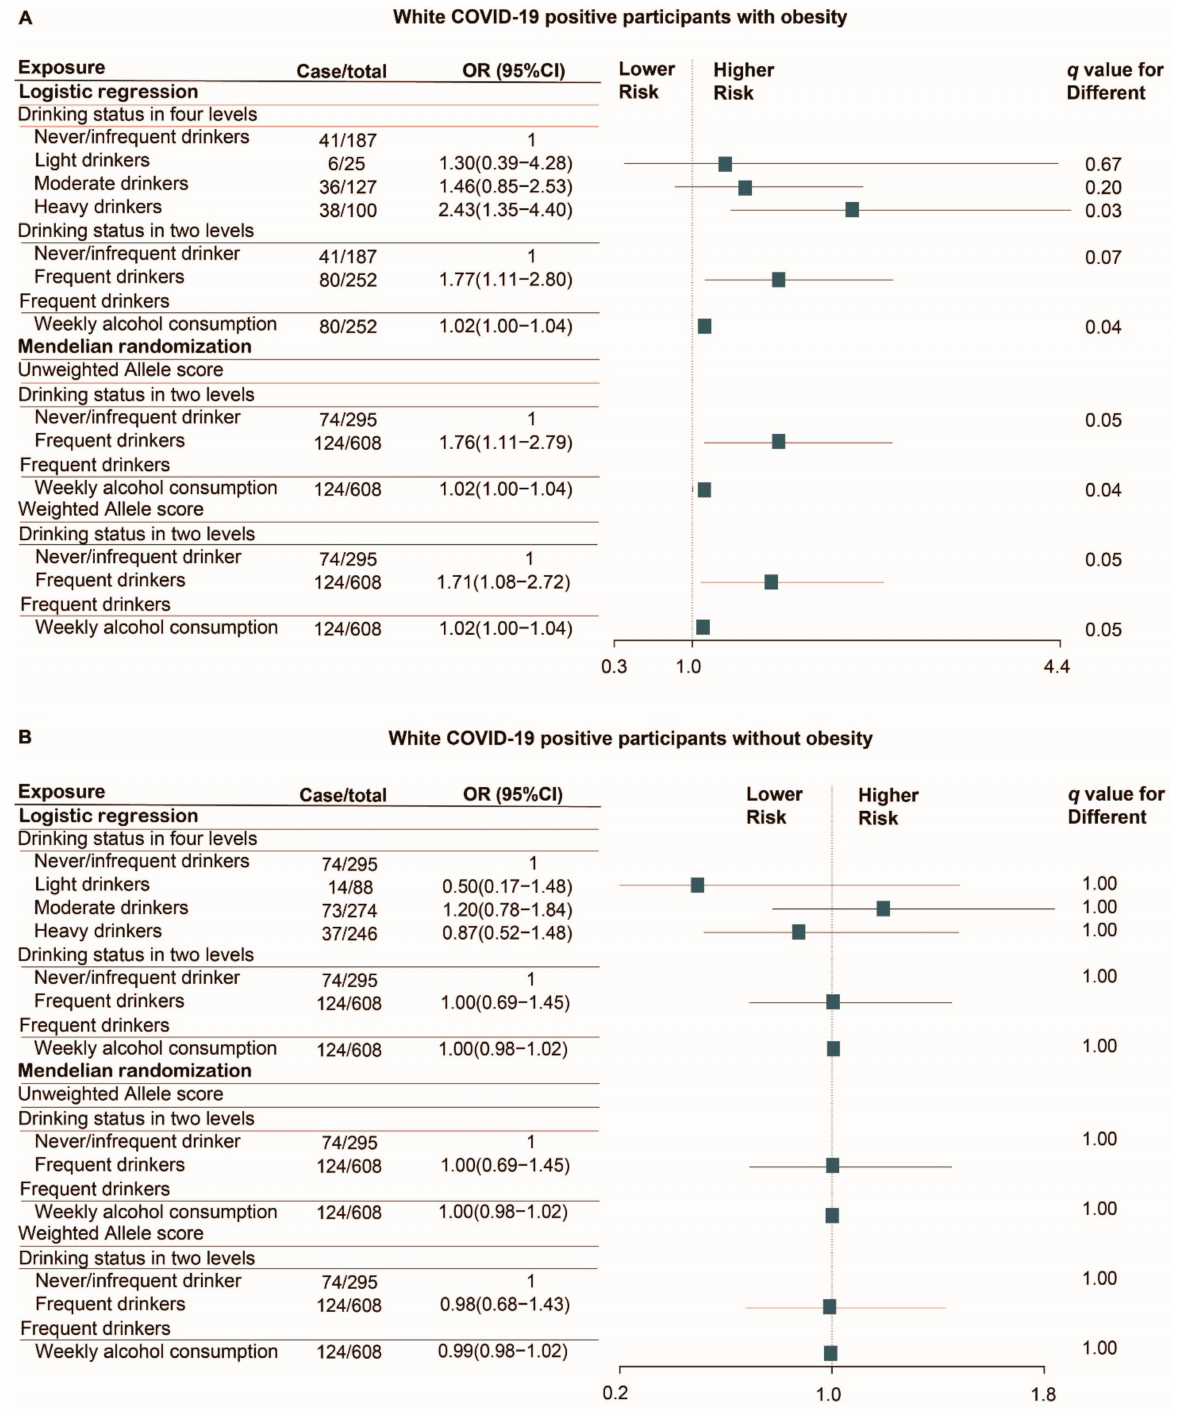
Figure 4. Logistic regression and Mendelian randomization analyses of the association of alcohol consumption with the risk of severe clinical outcomes in white COVID-19 positive patients with ( A ) and without obesity ( B ). Analyses were performed in PSM cohort (Number of cases was counted from the cohort before PSM). Matching factors for PSM including age, sex, BMI categories, current smoking status, alcohol related diseases, asthma, emphysema, COPD, bronchitis/bronchiectasis, esophagitis, gastritis/duodenitis, peptic ulcer, GERD, hypertensive, chronic ischemic heart disease, heart failure, diabetes, dementia, renal failure, liver cirrhosis and/or liver failure, tumor, and AIDS. q-value was calculated by false discovery rate (FDR) method. Abbreviation: OR, odds ratio; HR, hazard ratio; CI, confidence interval; PSM, propensity score matching; BMI, body mass index; GERD, gastroesophageal reflux disease; COPD, chronic obstructive pulmonary disease; AIDS, acquired immunodeficiency